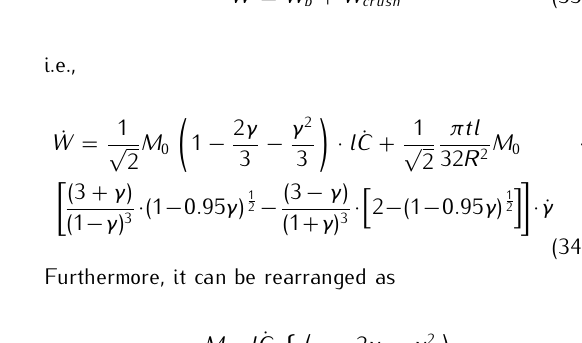
Figure 3. Variation of θ C with respect to the parameter γ